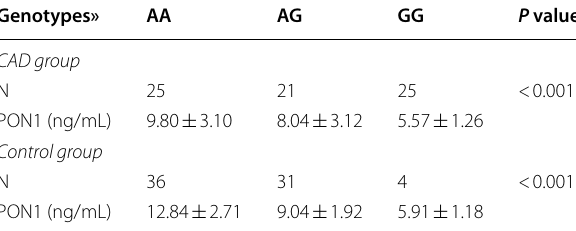
All values are expressed as mean standard deviation, PON1 paraoxonase1 ± Table 5 Comparison of serum PON1 levels between CAD and control group within the same genotype Genotype